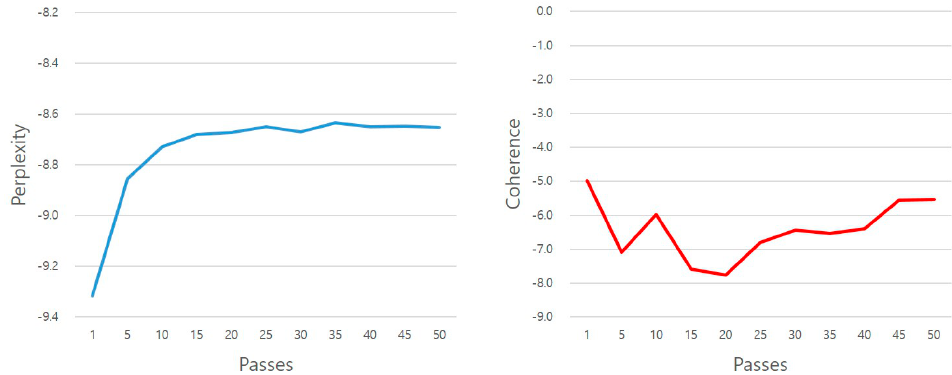
Figure 3. Example of graph of confusion score and consistency score according to Passes.